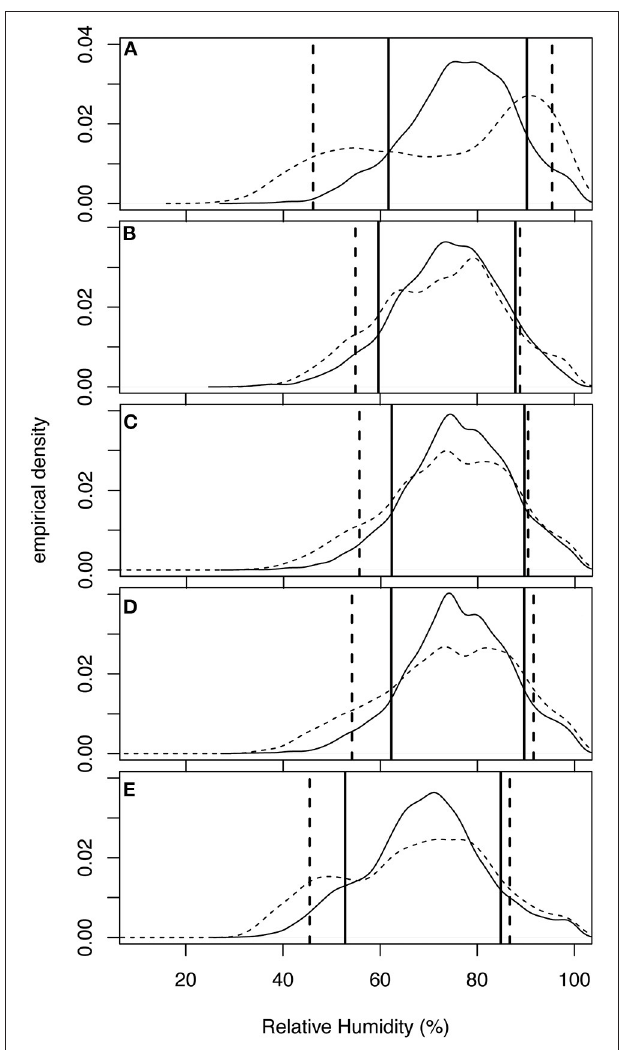
FIGURE 11 | Same as Figure 9 but for daily relative humidity.